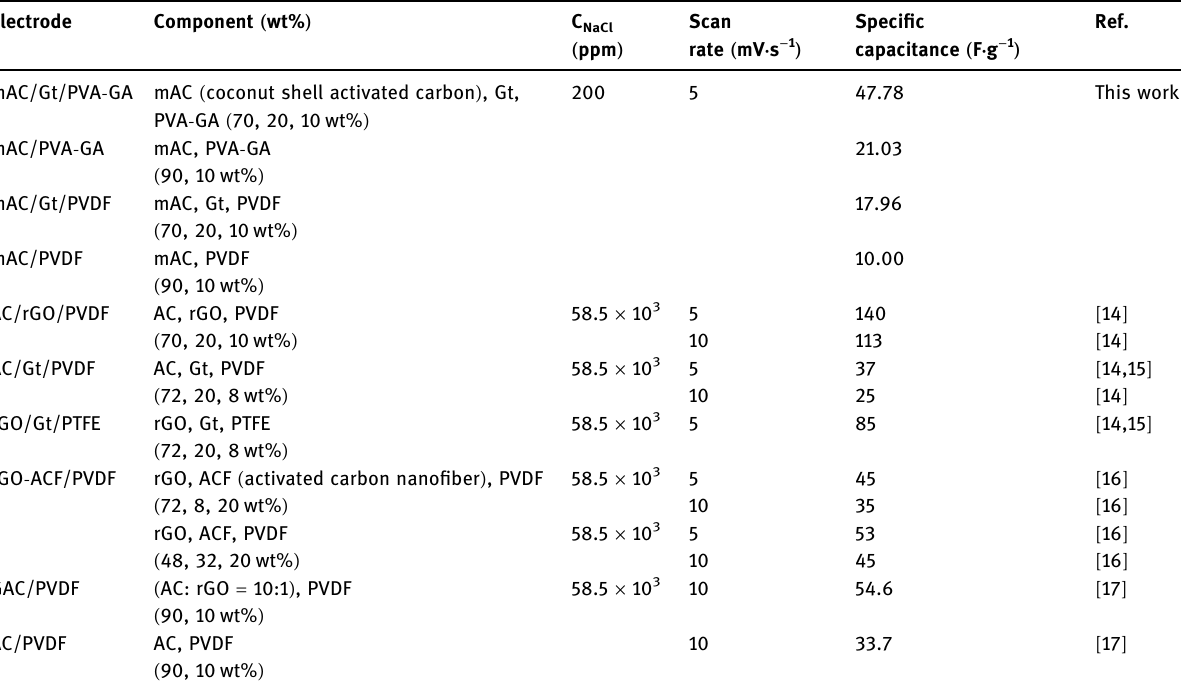
Table 1: Comparison of speci fi c capacitance of various carbon - based composite electrodes Electrode Component ( wt% ) Ref.